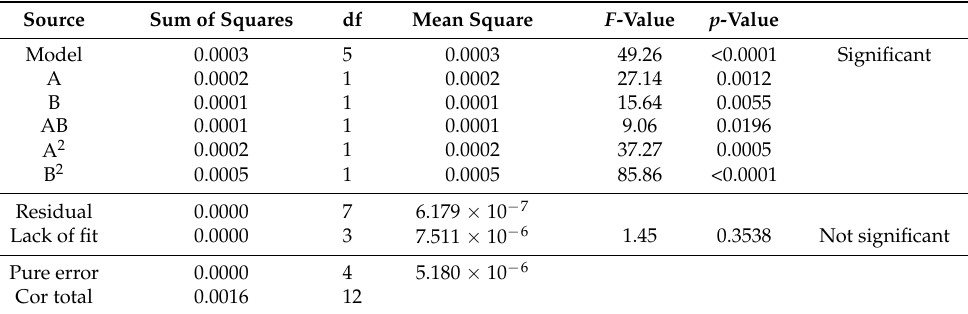
Table 2. The ANOVA analysis of vitamin B12 extracted from the oven-dried U. lactuca samples that employed the UAE